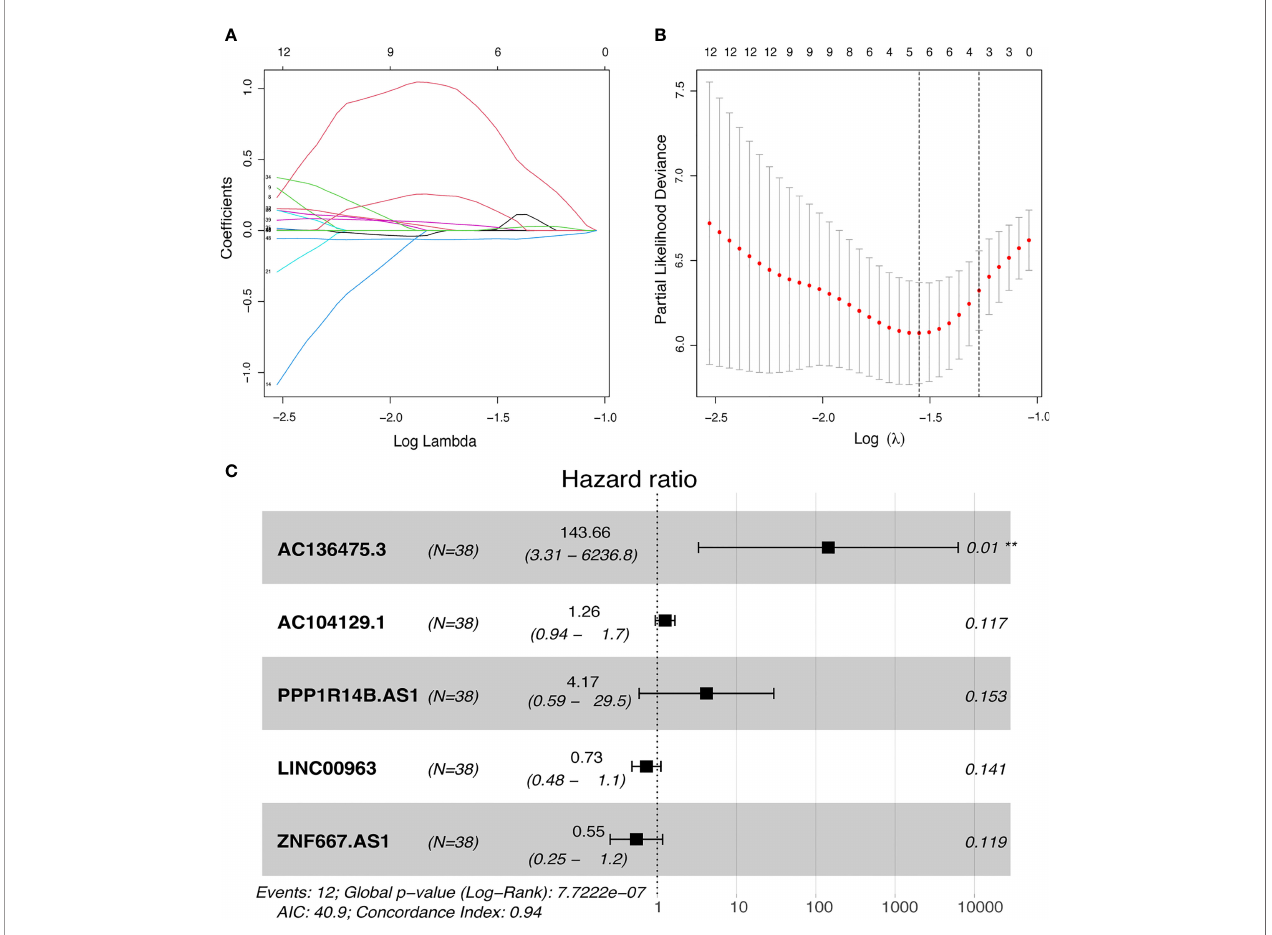
FIGURE 3 | Development of FRLs signature. (A, B) LASSO regression model of the prognostic FRLs. (C) Forest plot of fi ve FRLs revealed by multivariate Cox regression. ** p <